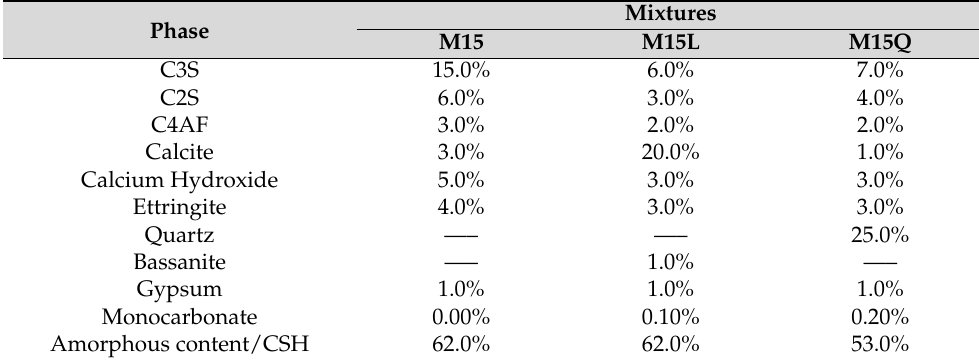
Table 4. Phase distribution obtained through the Rietveld refinement method for the paste fractions of mixtures M15, M15L and M15Q, after 91 days of standard